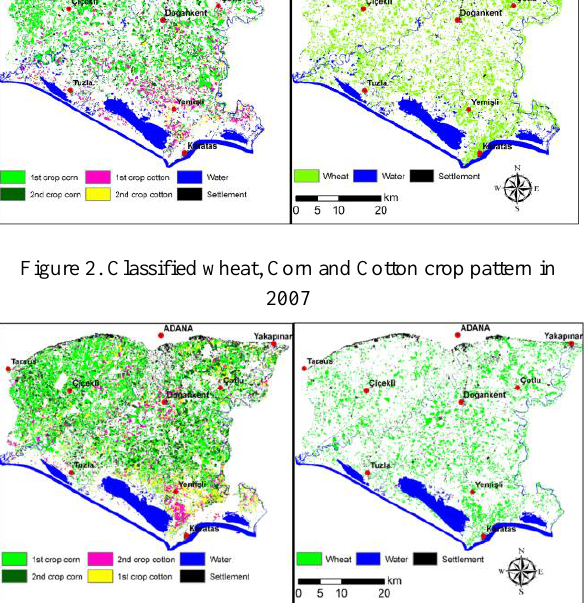
Figure 3. Classified wheat, corn and cotton areas in 2013